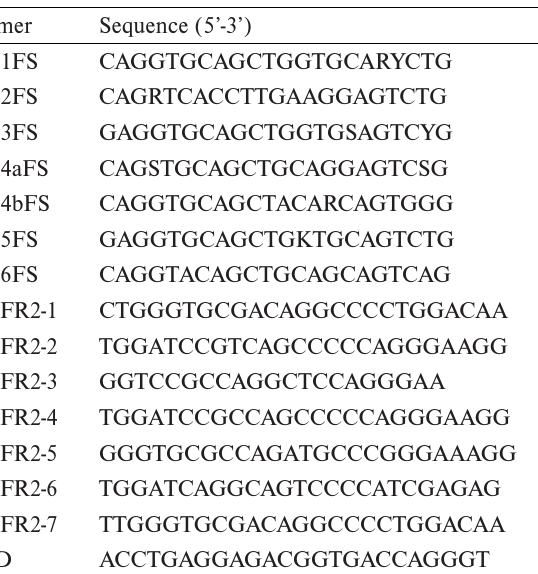
Table 2. Sequences of the consensual primers used for IgH rearrangement